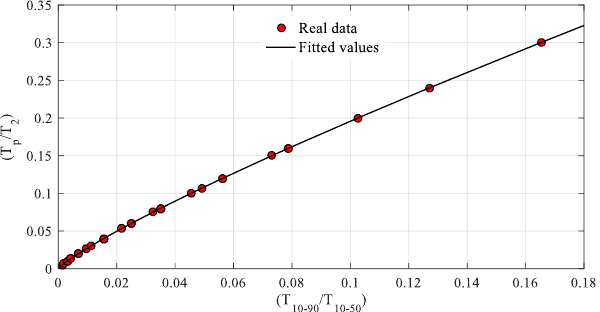
Figure 4. Real data and fitted values of T p / T 2 versus T 10 – 50 / T 10 – 90 . From the data of T p / T 2 and T 10–50 / T 10–90 , the fitting curve can be determined by a non-linear regression based on a Levenberg–Marquardt algorithm [19]. The expression of the fitted curve is given as Equation (19). From Equation (19) and the required T 2 , T p can be calculated by Equation (20). U p can also be determined by searching for the crest voltage of the considered waveform. It is noted that the approach for the crest voltage determination is the same as those of the standard and previously developed methods [1,16].